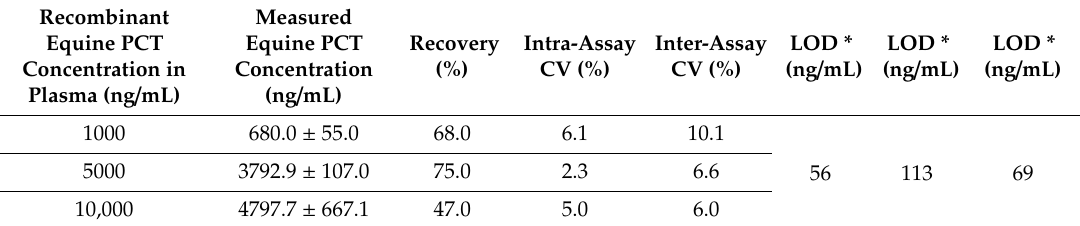
Table 4. Validation parameters of the hPCT ELISA kit obtained in the plasma samples spiked with